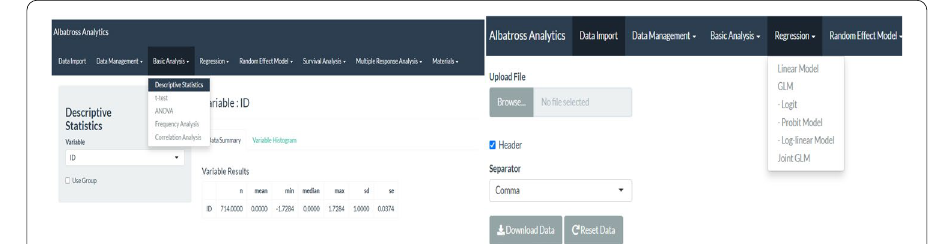
Fig. 3 Basic analysis and